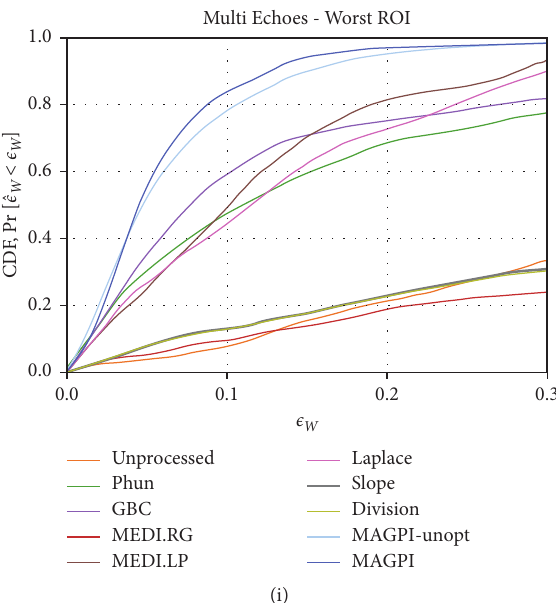
Figure 6: The CDFs for each acquisition and phase estimation method pair. Each column corresponds to a different type of acquisition: single-echo acquisitions (SEGE) are shown in the first column, accelerated acquisitions with sEPI in the second, and multiecho acquisitions (MEGE and MAGPI) in the third. The first row (a–c) shows the CDF when all the error data is pooled, over all voxels, slices, tubes, and background ROIs. Given the large variability in performance for different background ROIs, we show in the second (d–f) and third (g–i) ( 0 . 1 ) , respectively. A highly reproducible method will have a rows the CDFs obtained in the ROIs with the maximum and minimum F ϵ r similar curve shape across all Table 4: Probability of relative errors < 0.1 in the background ROI that maximizes F ( 0 . 1 ) across sequences, scan variability (ID is as listed ϵ r in Table 1), and phantom tube components. The tube contents are 1.0mM GdCl 3 in tubes 1 and 2, 0.5 mM GdCl 3 in tubes 3 and 4, and